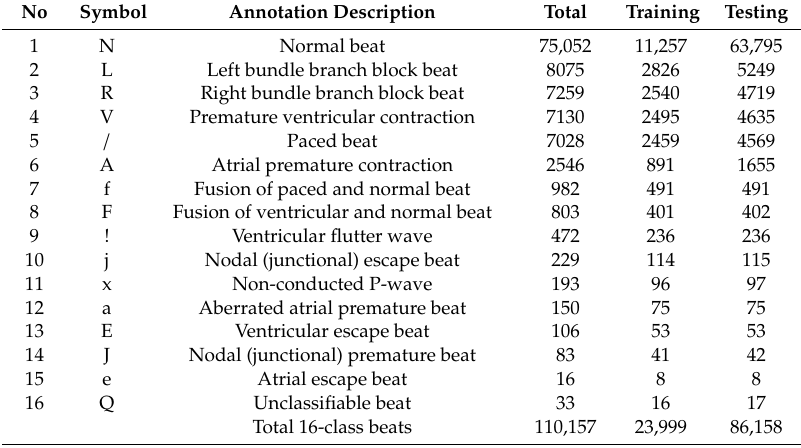
Table 1. Sixteen classes of cardiac arrhythmia ECG beats from the MIT-BIH Database and its amount of Training and Testing beats.